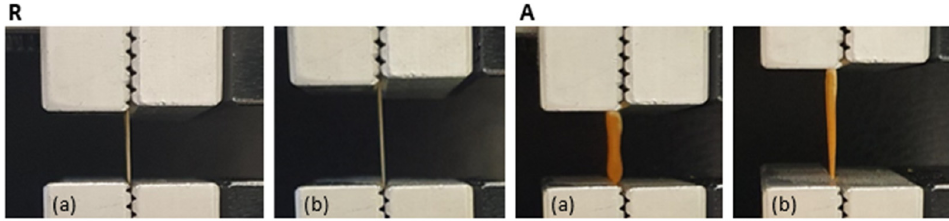
Figure 7. Macroscopic pictures of random (R) and tubular aligned (A) scaffolds at relaxed ( a ) and elongated state ( b ). As seen in Figure 8, panel a, the scaffold local mobility is also released upon wetting with either H 2 O or D 2 O. Measurements performed in D 2 O (squares), enhancing the visi-